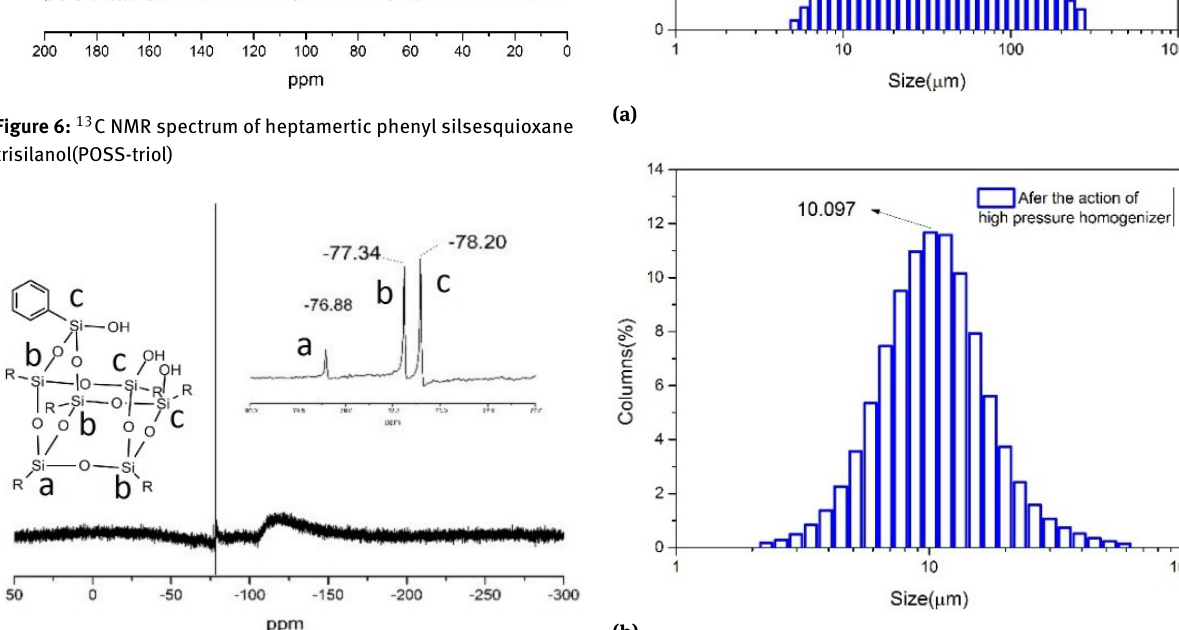
the effect of hydroxyl between wollastonite and POSS-triol, and improve its binding degree.